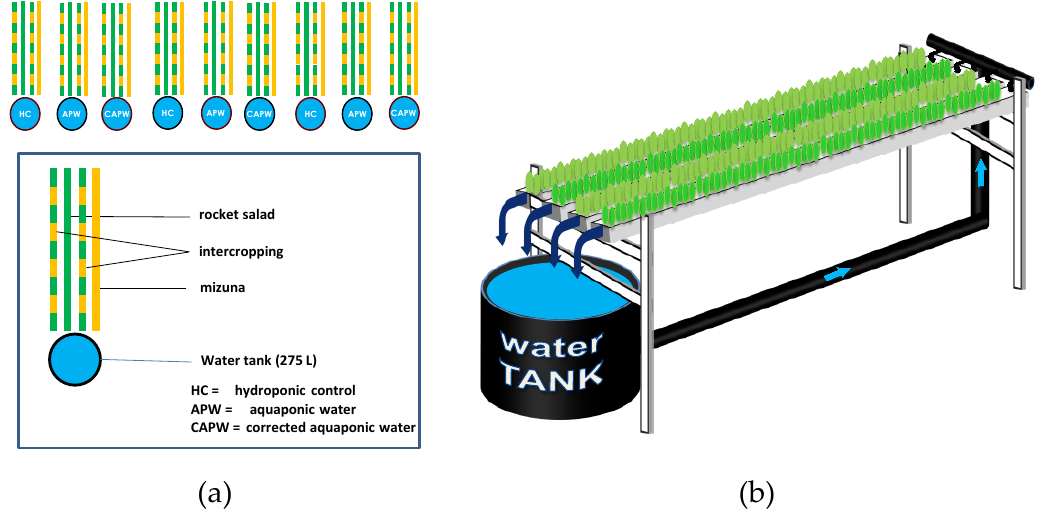
Figure 2. Overview of the experimental design ( a ) and a single cultivation mesocosms ( b ).